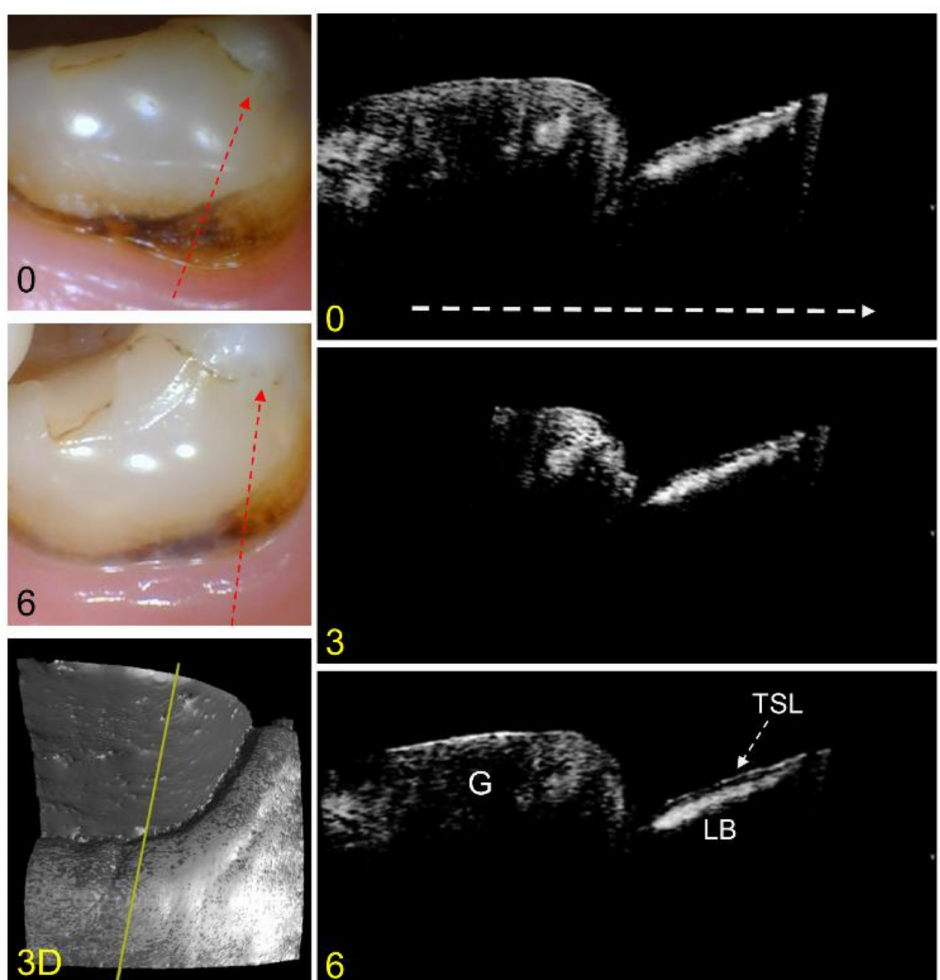
Figure 2. Color pictures at baseline and 6 months are shown for an arrested lesion. The dashed red lines show the likely position of the three CP-OCT b-scans shown at baseline, 3 months, and 6 months. The white dashed arrow in the OCT b-scan is directed from the root to the crown. A surface rendering (3D) of the entire CP-OCT scan taken at baseline is also shown, with the yellow line showing the position of the extracted b-scans. The position of the gingiva (G) and the lesion body (LB) with the TSL located on top of the lesion are indicated. Little change has occurred for the lesion over 6 months. A second lesion that is active with advancing cavitation is shown in Figure 3. In the color image, a shadow is visible just above the exposed lesion area at the baseline and that area is no longer visible at month 6. It is hard to determine from the color images whether or not the lesion area is larger. The surface renderings of the CP-OCT scans that are shown at the baseline and 6 months show that the area of cavitation is larger, and that the area near the top of the lesion has collapsed. The CP-OCT scan at the baseline extracted at the position of the yellow line shows the gingiva on the left and a cavitated lesion area on the right, along with the mostly transparent sound enamel. A small lesion area (LB) is visible just below the enamel, demarcated by the orange arrows. That lesion area between the orange arrows becomes cavitated after 6 months in the lesion area. The depth lost was measured to be 151 µ m from 0–3 months and 296 µ m from 3–6